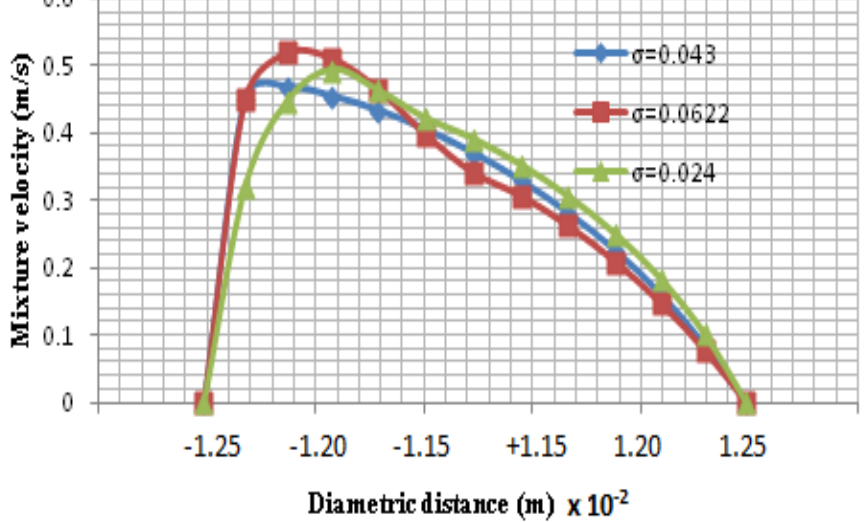
Figure 9. Surface tension affecting the diametric variation of mixture velocity